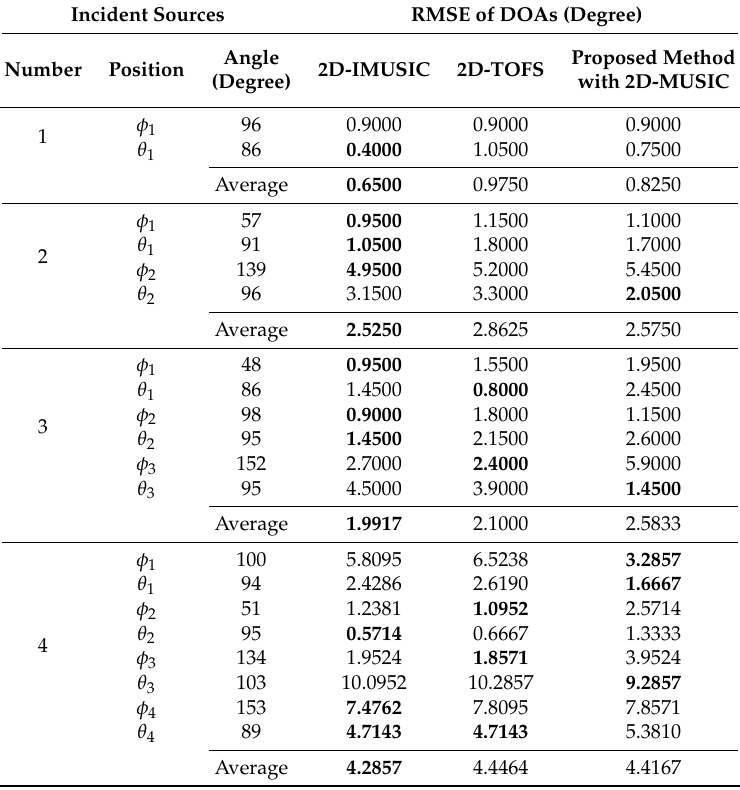
Table 6. Performance evaluation on Experiment 2. The boldfaced results highlight the optimal minimum